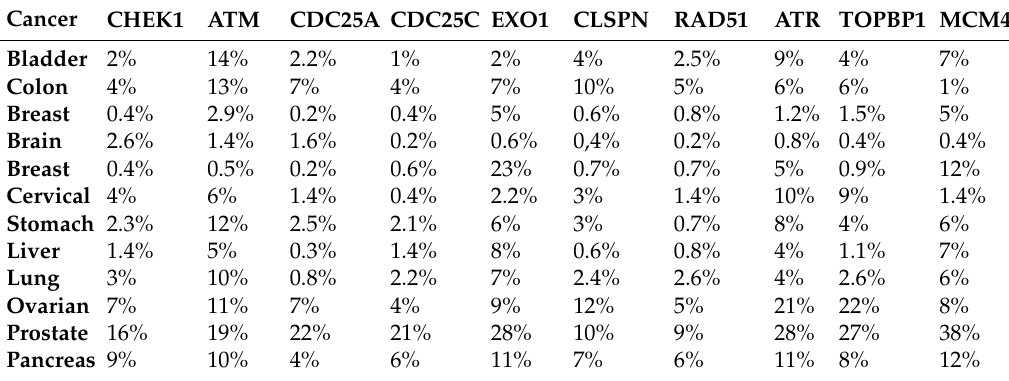
Table 3. Genetic alteration summary of genes of interest in 12 solid